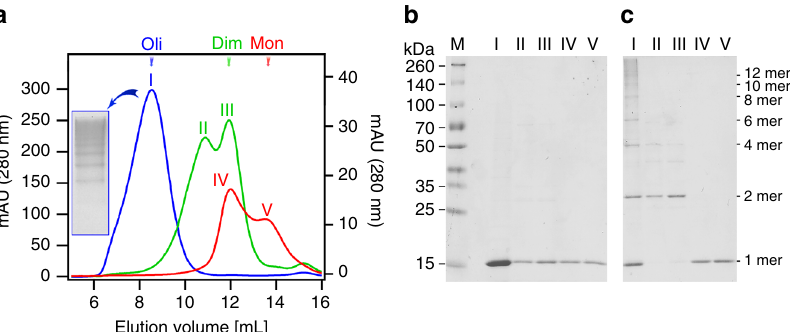
Fig. 1 Quaternary structures of rh Bri2 BRICHOS. a SEC on Superdex 200 PG of rh Bri2 BRICHOS cleaved from individual rh NT*-Bri2 BRICHOS fusion protein species (see Supplementary Fig. 1). Oligomers (blue curve, absorbance scale on the left), dimers (green curve, absorbance scale on the right), and monomers (red curve, absorbance scale on the left). Inset shows native PAGE of the oligomer fraction. The different fractions indicated by Roman numerals in a were analyzed by SDS-PAGE under reducing b and non-reducing c conditions. Lane M in b shows migration of protein size markers with masses indicated to the left. The numbers of Bri2 BRICHOS monomer subunits likely present in the different species resolved in c are given to the